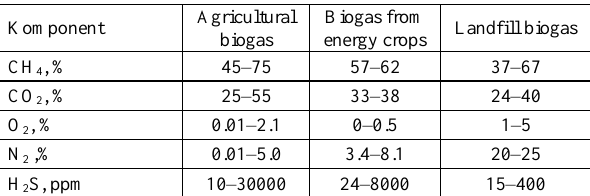
Table 2. The composition of biogas depending on the method of its pro- Komponent